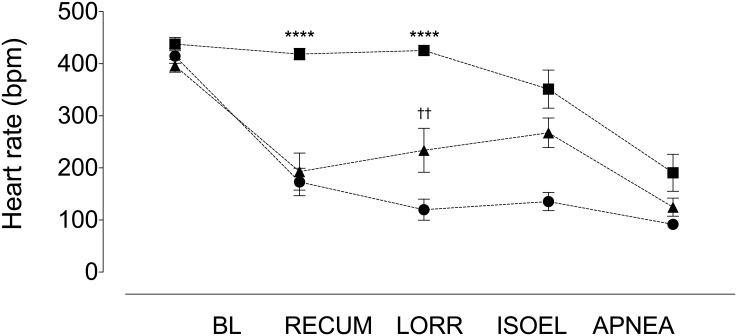
Heart rates in the carbon dioxide (circles) and carbon dioxide-oxygen (triangles) treatment groups decrease significantly compared to the isoflurane group (squares) at recumbency (RECUMB, **** p < 0.0001, both comparisons) and loss of the righting reflex (LORR, **** p < 0.0001, both comparisons).At LORR, heart rates are significantly increased in the carbon dioxide-oxygen group compared with the carbon dioxide group (†† p = 0.008). ISOEL, isoelectric electrocorticograph. Data are mean ± SEM.